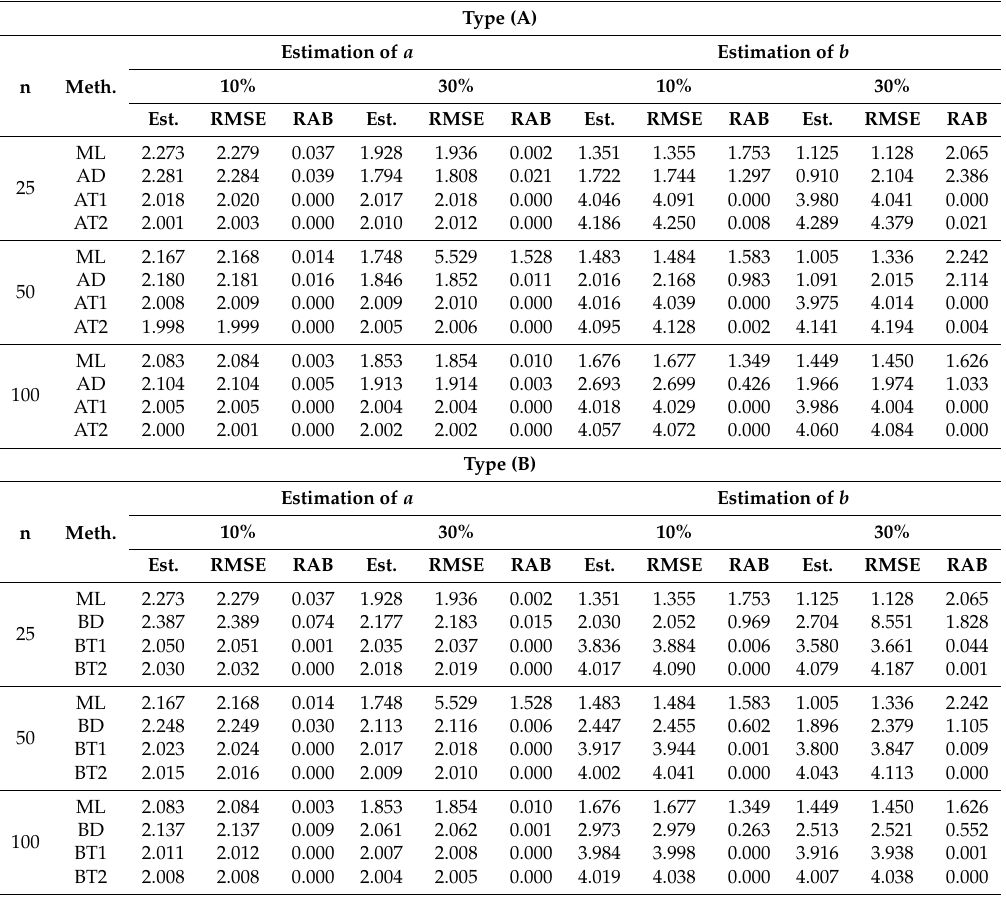
Table 2. The estimates, root of mean square error (RMSE) and relative absolute biases (RABs) for two parameters of the Weibull distribution using TL-moments, direct L-moments, and ML method based on left censoring ( a = 2 and b = 4) in the presence of